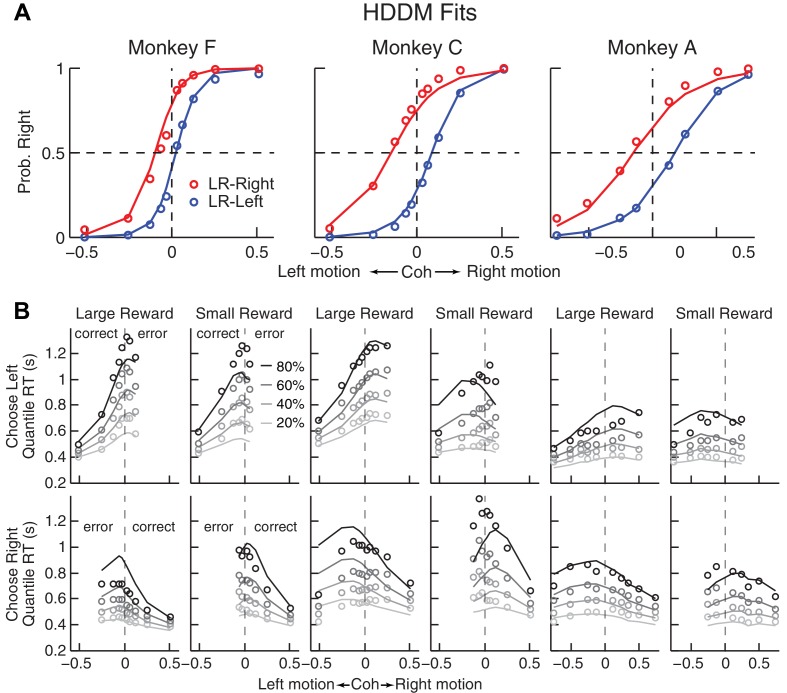
Comparison of choice and RT data to HDDM fits with both momentary-evidence (me) and decision-rule (z) biases.(A) Psychometric data (points as in Figure 2A) shown with predictions based on HDDM fits to both choice and RT data. B, RT data (circles) and HDDM-predicted RT distributions (lines). Both sets of RT data were plotted as the session-averaged values corresponding to the 20th, 40 th, 60th, and 80th percentiles of the full distribution for the five most frequently used coherence levels (we only show data when > 40% of the total sessions contain >4 trials for that combination of motion direction, coherence, and reward context). Top row: Trials in which monkey chose the left target. Bottom row: Trials in which monkeys chose the right target. Columns correspond to each monkey (as in A), divided into choices in the large- (left column) or small- (right column) reward direction (correct/error choices are as indicated in the left-most columns; note that no reward was given on error trials). The HDDM-predicted RT distributions were generated with 50 runs of simulations, each run using the number of trials per condition (motion direction × coherence × reward context × session) matched to experimental data and using the best-fitting HDDM parameters for that monkey.10.7554/eLife.36018.011Figure 3—source data 1.Source data for Figure 3—figure supplement 2.Collapsing-bound model fitting parameters and goodness of fits for each session.